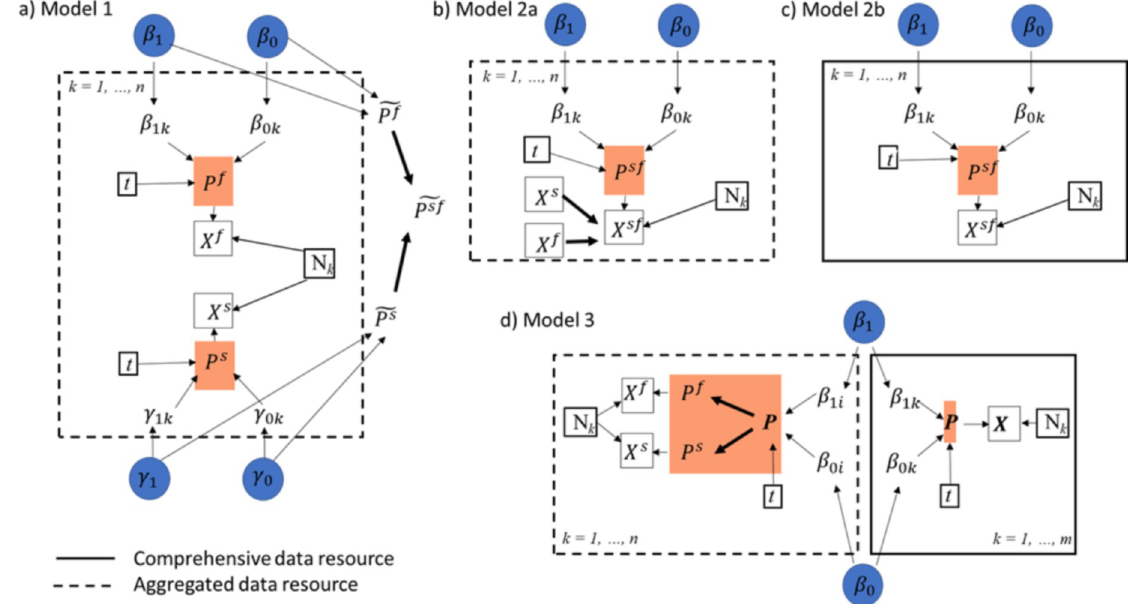
Fig 2. Directed acyclic graphs (DAGs) for models to assess aggregated (a, b), comprehensive (c) or both aggregated and comprehensive ( d ) data. Models 1, 2a and 2b represent models previously used in this field and Model 3 is the new approach. Model 2a depicts the original analysis in [3]. In each case, β 0 and β 1 are the shared intercept and time coefficients in the linear component of the logistic regressions, and likewise γ 1 and γ 0 for Model 1 which has separate sub-models for fed and dead. X denotes the count data and N are the total counts of mosquitos in each subgroup. (a) Mosquitoes are counted as killed with no information on whether they are also blood fed ( X f ) or unfed without information that mosquitoes are also killed ( X d ). We can infer marginal probabilities (shown in orange boxes) then (assuming independence), after estimating the probability of either outcome ( e P f and f P sf ), infer the probability that mosquitoes are both alive and blood fed ( f P sf ). b) Alternatively, we can adjust the data using the same assumption of independence prior to fitting the model and fit a logistic binomial model to the adjusted data. c) The same model structure (Model 2) can be fitted to the comprehensive data. d) Using evidence synthesis, we can learn from the comprehensive data ( N = 2 datasets) to infer probabilities that are supported by the aggregated data ( N = 23 datasets). For each dataset k represents the study index and t is the time point at which data are